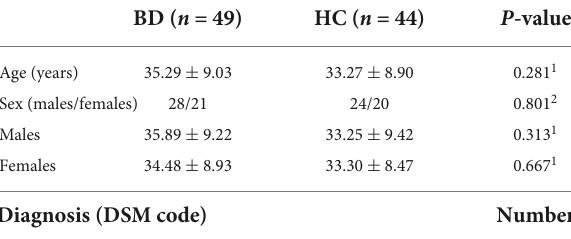
TABLE 1 Participant demographics and primary diagnosis information for bipolar disorder (BD)